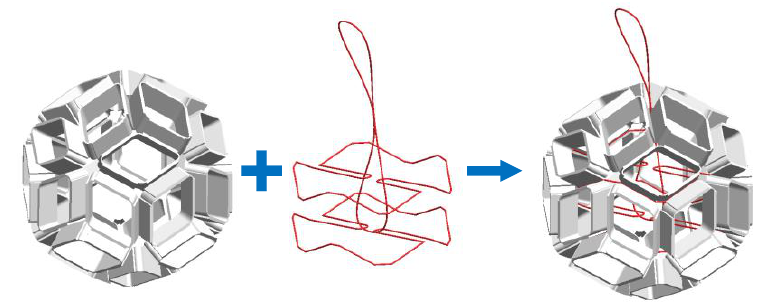
Figure 16. Winding method of driving ropes.